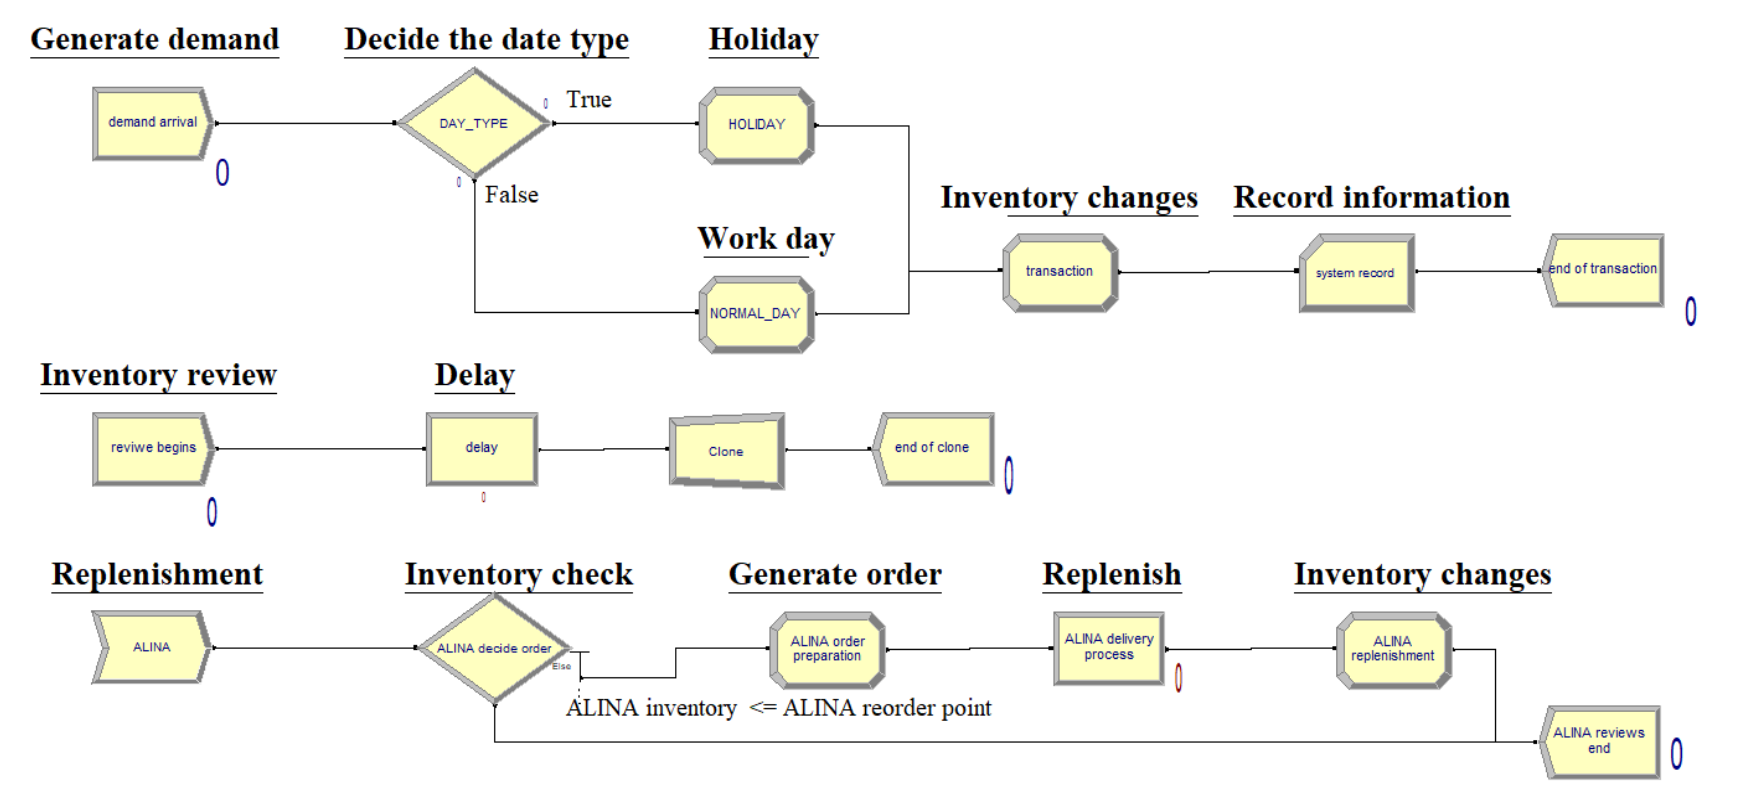
Figure 8. Daily check and replenishment processes of the outpatient drug inventory simulation model by using Arena.